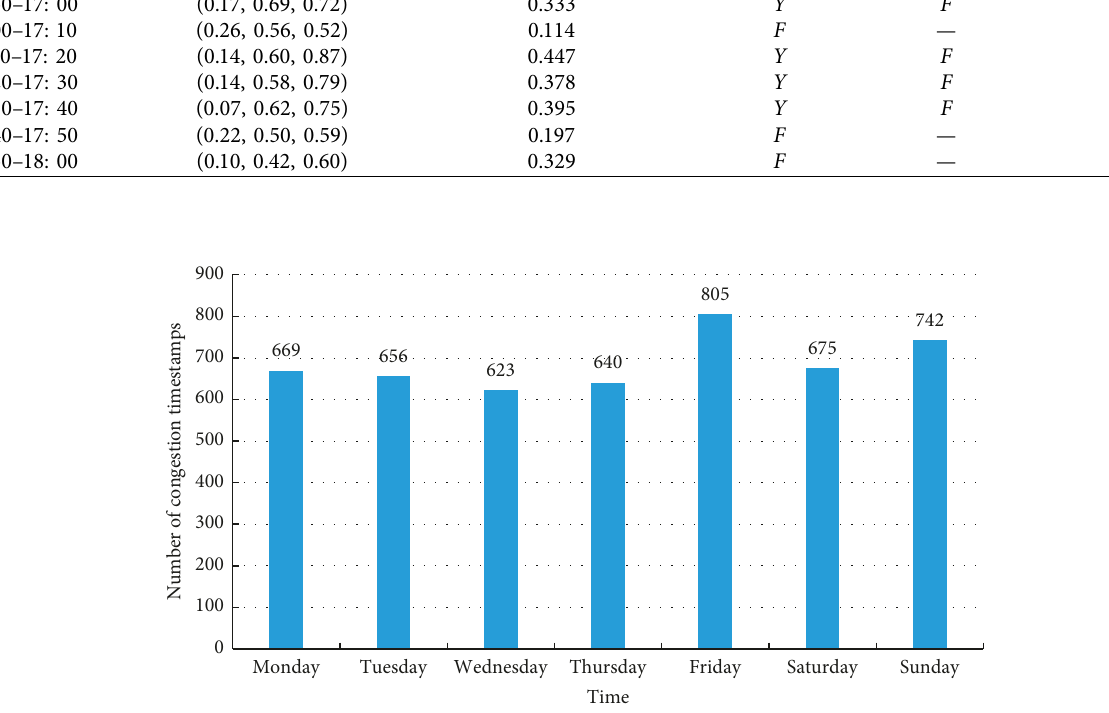
Figure 10: Congestion statistics of all grids for each day.